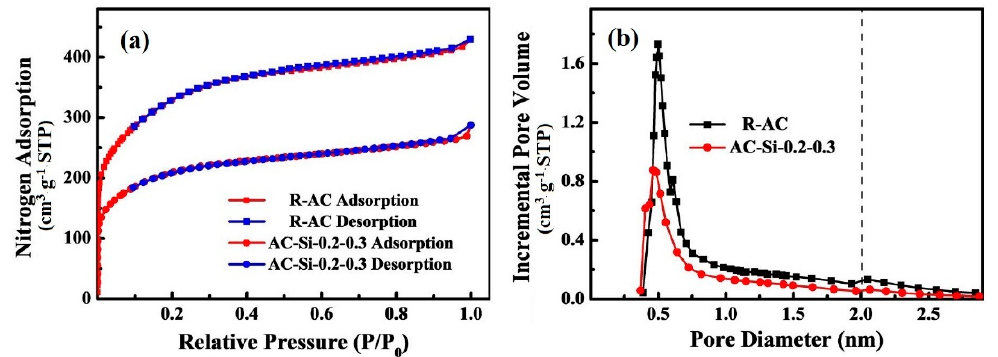
Figure 7. ( a ) The nitrogen adsorption-desorption isotherms and ( b ) the pore diameter distributions of AC-Si-0.2-0.3 and R-AC.